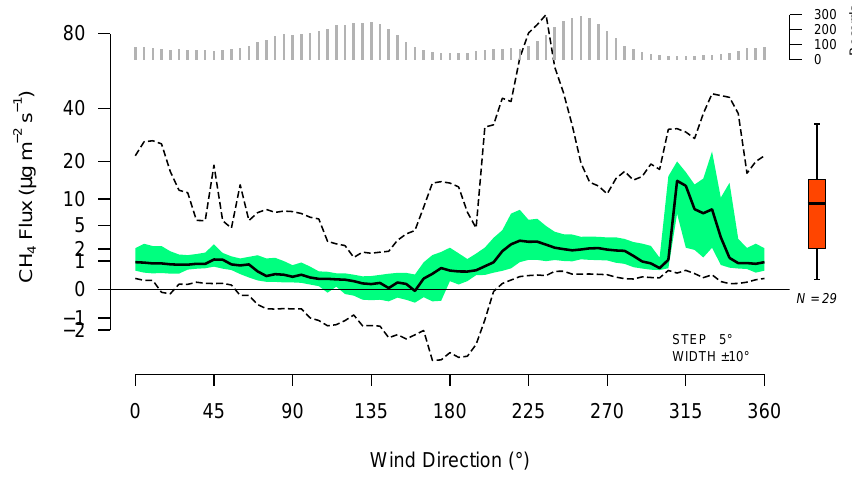
Fig. 5. Methane fluxes as a function of wind direction. Data were aggregated for overlapping wind direction sectors of 10 ◦ with 50% overlap. Median (bold line), interquartile range (shaded area; 50% of all values), and maximum and minimum values (dashed lines) are shown. The top inset shows the number of records available for each wind direction sector, and the box and whisker plot at right shows the range of CH 4 fluxes obtained by floating chambers. Note that CH 4 fluxes were always positive when wind was approaching over the lake surface (220 to 10 ◦